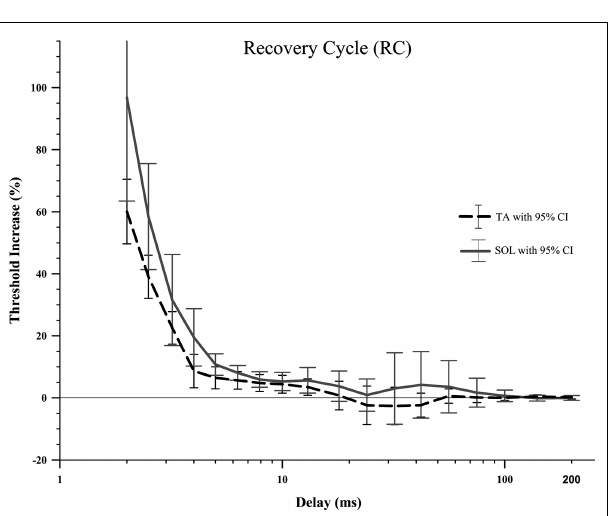
FIGURE 4 |The recovery cycle in the ratTA and SOL motor axons did not show a period of superexcitability followed by subexcitability, just a slowly decaying relative refractory period. AWilcoxon signed-rank test did not find any significant differences betweenTA and SOL axons at any of the 18 delays. It should be noted that the large number of delays (18) that were compared created a very small adjusted alpha level, 0.003.Therefore there is an increased risk of type 2